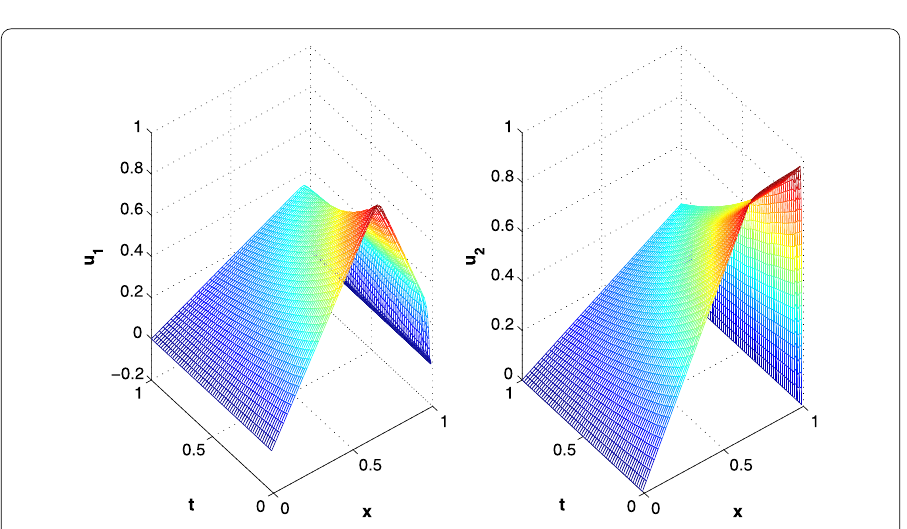
Figure 7 Exact solution of Example 5.2 for N = M = 64, ε 1 = 10 –2 , and ε 2 = 10